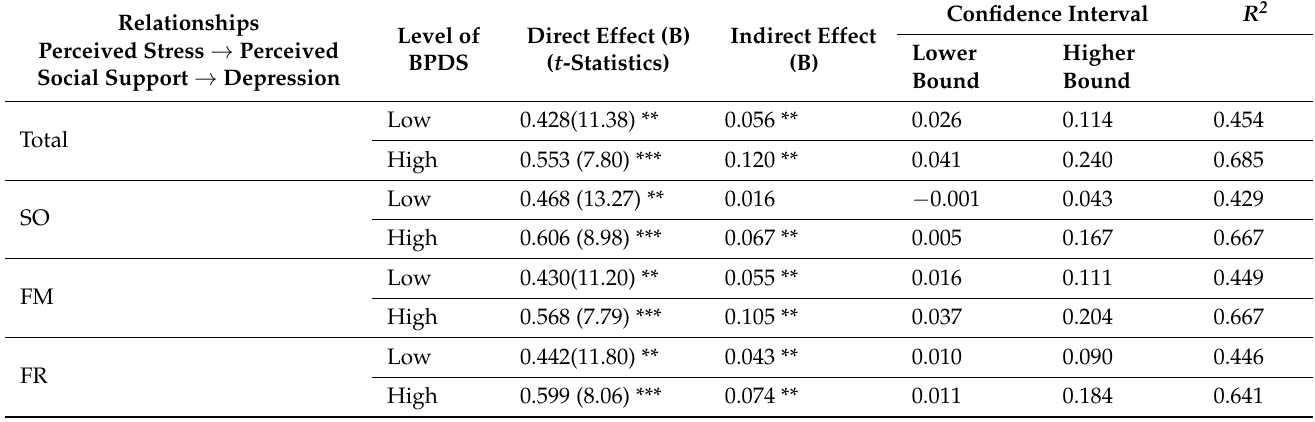
Figure 4. Mediation model of perceived stress, social support, and depression for low levels of borderline personality symptoms. X = predictor; M = mediator; Y = outcome; a, b, c, c (cid:48) = path coefficients; c = total direct effect of perceived stress on depression; c (cid:48) = direct effect of perceived stress on depression controlling for perceived social support. Values for depression (Y) are the R-square. BPDS = borderline personality disorder symptoms. *** p < 0.001. Table 3. Summary of the indirect and indirect effects of the mediation models, adjusted for age, sex, and level of